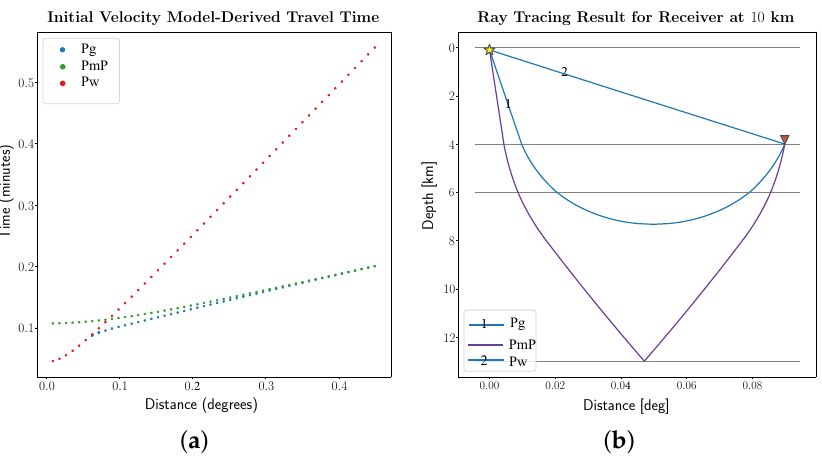
Figure 6. Calculation of theoretical travel time curve. ( a ) Travel time curves of three main phases, with epicentral distance ranging from 1 to 50 km (1 ◦ 111.32 km). ( b ) The theoretical propagation ≈ paths of the three main seismic phases in ( a ) received by the sensor at 10 km. The star represents the source of the explosion, and the inverted triangle represents the